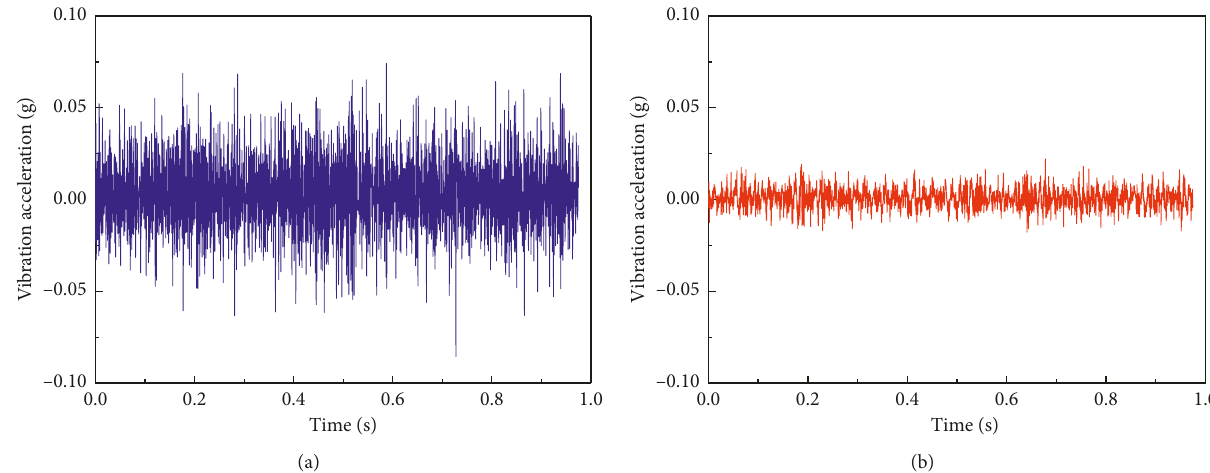
Figure 2: Time domain vibration signal of the work roll: (a) vibration acceleration in the vertical direction; (b) vibration acceleration in the horizontal direction.